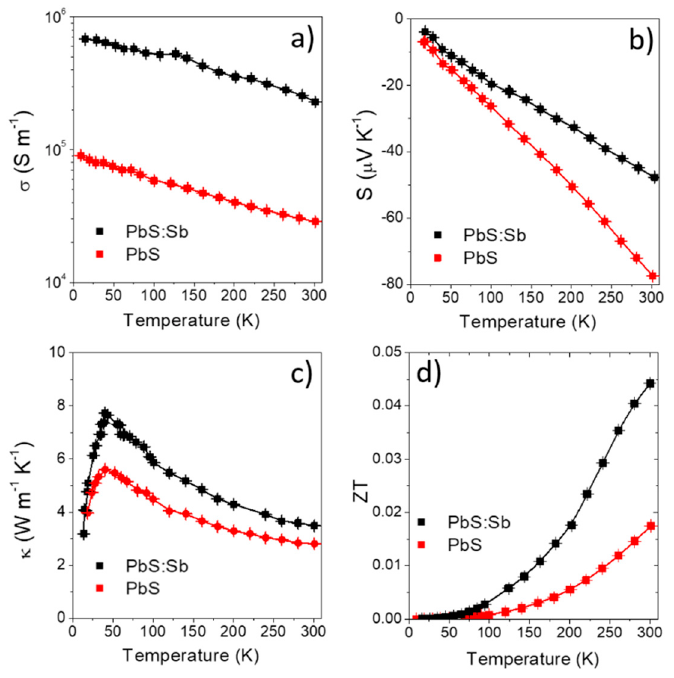
Figure 4. ( a ) Electrical conductivity, ( b ) Seebeck coefficient, ( c ) thermal conductivity and ( d ) thermoelectric figure of merit of PbS (red) and Pb 0.9 Sb 0.1 S (black) nanomaterials.